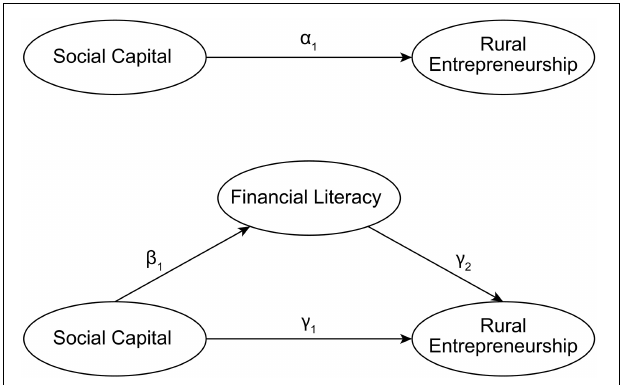
FIGURE 1 | Relationships between Social Capital, Financial Literacy and Rural